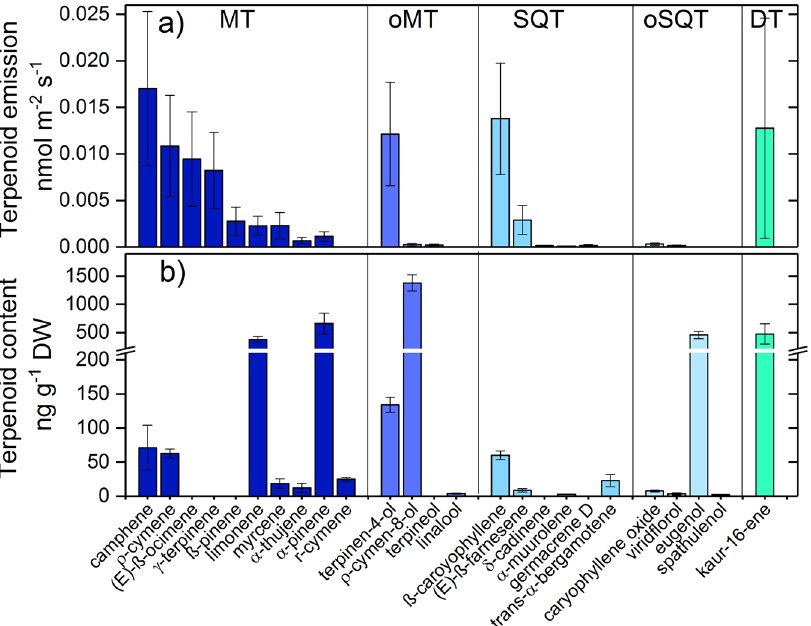
Figure 4. Isoprenoid emission rates ( a ) and leaf isoprenoid concentrations ( b ) of H . halimifolium determined with TD-GC-MS. Leaf isoprenoid concentration was determined from five H . halimifolium individuals. For the isoprenoid emission measurements three different H . halimifolium individuals were used. MT stands for monoterpenes, oMT stands for oxygenated monoterpenes, SQT stands for sesquiterpenes, oSQT stands for oxygenated sesquiterpenes and DT stands for diterpenes.